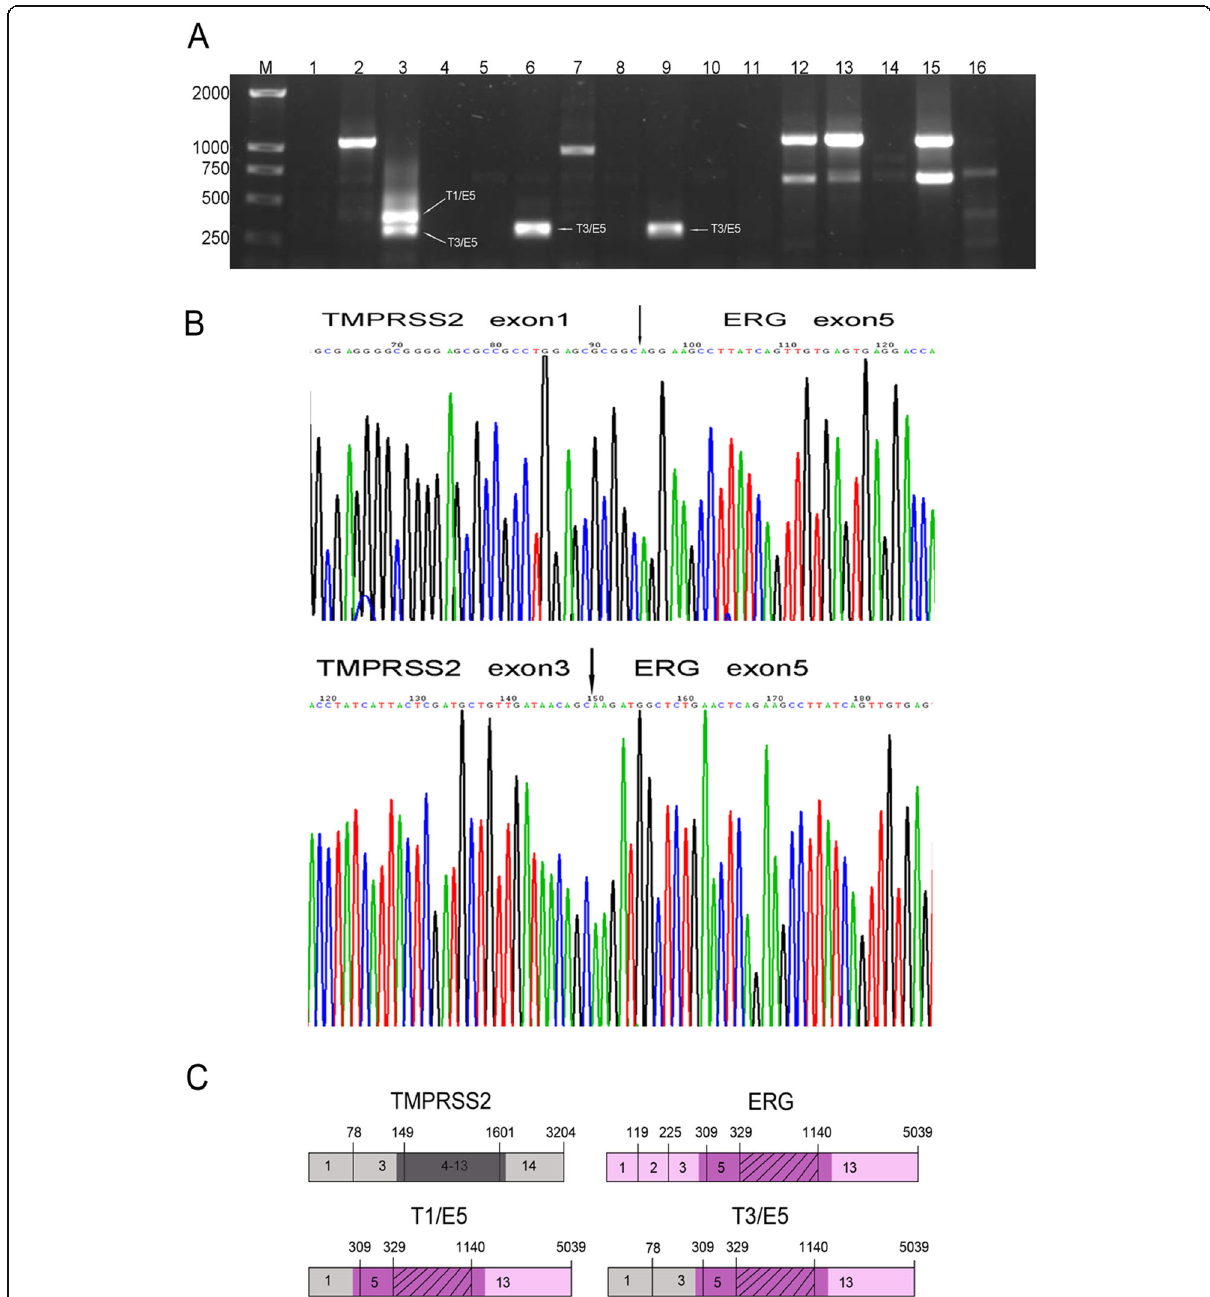
Fig. 1 Detection of TMPRSS2: ERG hybrid transcripts in needle biopsy samples from Chinese PCa patients. a Representative gel electrophoresis results of TMPRSS2: ERG gene fusion as detected by nested-PCR. M, molecular markers; lane 1, negative control; lanes 2 – 15, PCa samples; lane 16, BPH sample. b The PCR products were extracted from the gel, then subcloned into the pMD19-T vector. The hybrid transcripts were identified by sequencing. c The schematic structure of the TMPRSS2 (NM_005656.3) and ERG (NM_004449.4) transcripts, as well as their hybrid mRNAs. The coding region is shown in deep